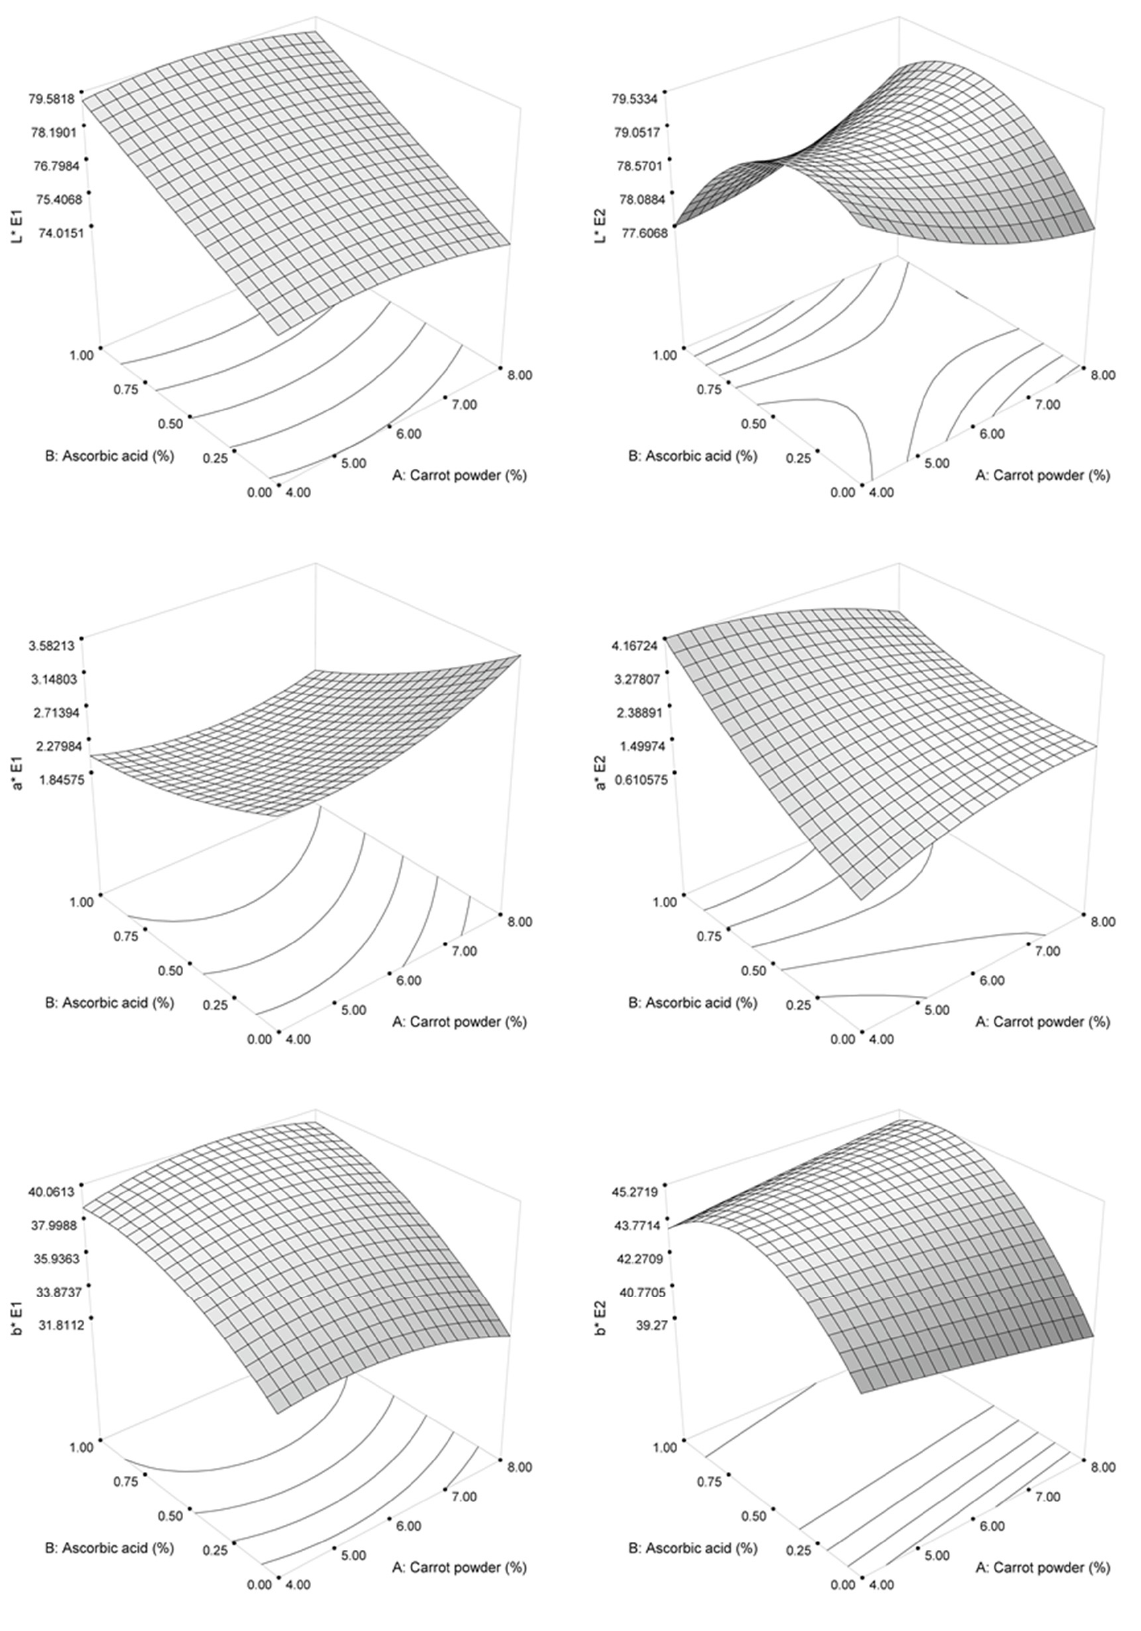
Figure 1. Response surface plots for color values as a function of carrot powder level and ascorbic acid level.